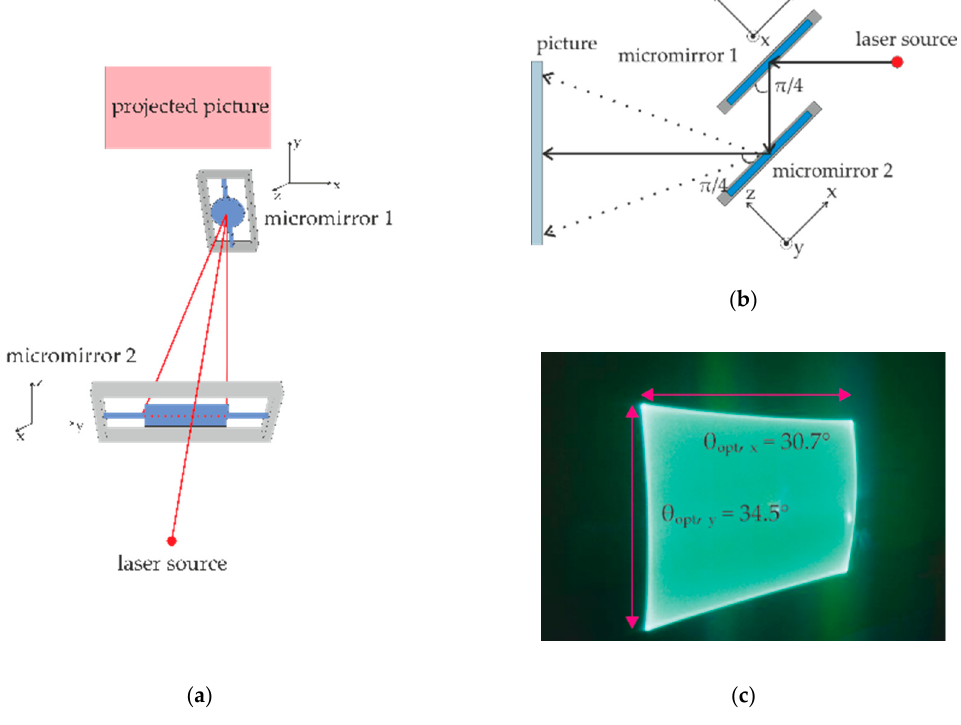
Figure 9. Setup and result of two single-axial micromirrors for 2D scanning: ( a ) Front view; ( b ) Side view; ( c ) Illuminated rectangle.